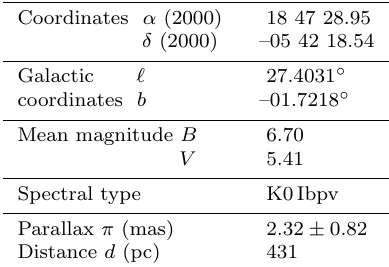
Table 1. Basic parameters of R Sct = HD 173819 (SIMBAD